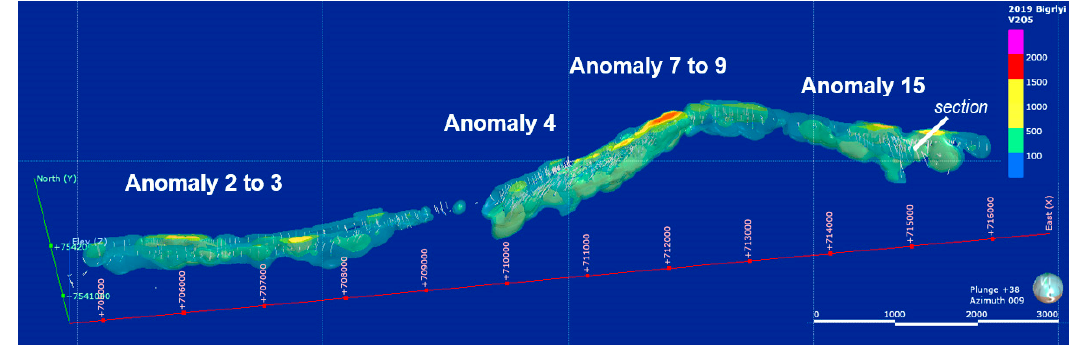
Figure 3. Three-dimensional model (spheroidal interpolated Leapfrog model) showing the distribution of V 2 O 5 mineralized shells (colors indicate grade in ppm V 2 O 5 ) across the Bigrlyi deposit, oblique view to north.